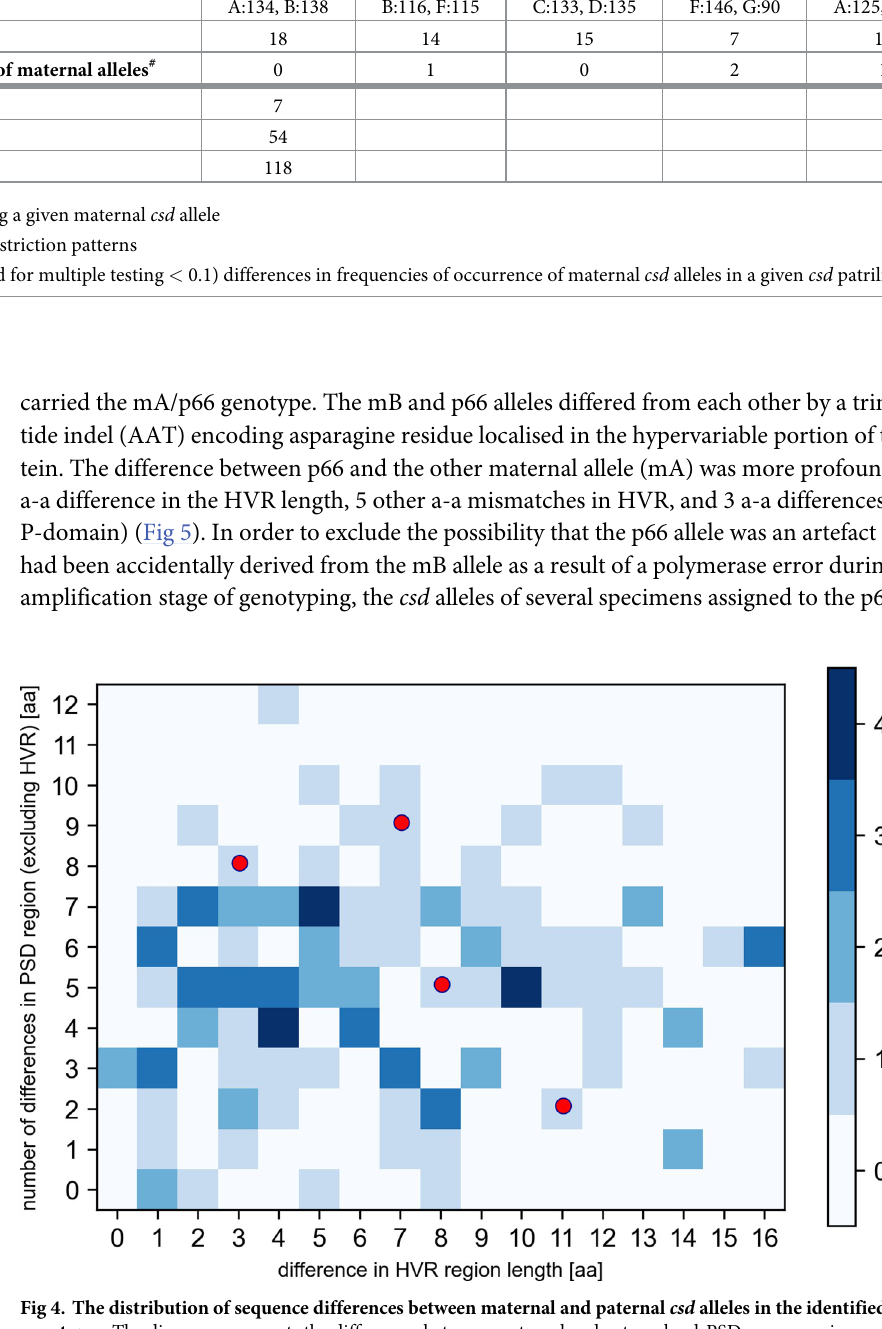
Fig 4. The distribution of sequence differences between maternal and paternal csd alleles in the identified genotypes. The diagram represents the differences between maternal and paternal csd-PSD sequences in genotypes detected in this study characterized by the difference in HVR (amino acid) length and the number of amino acid differences outside of the HVR (X- and Y-axis, respectively). Different shadings depict the number of genotypes characterized by a given set of parameters. Red dots represent the genotypes identified as underrepresented in the analysed